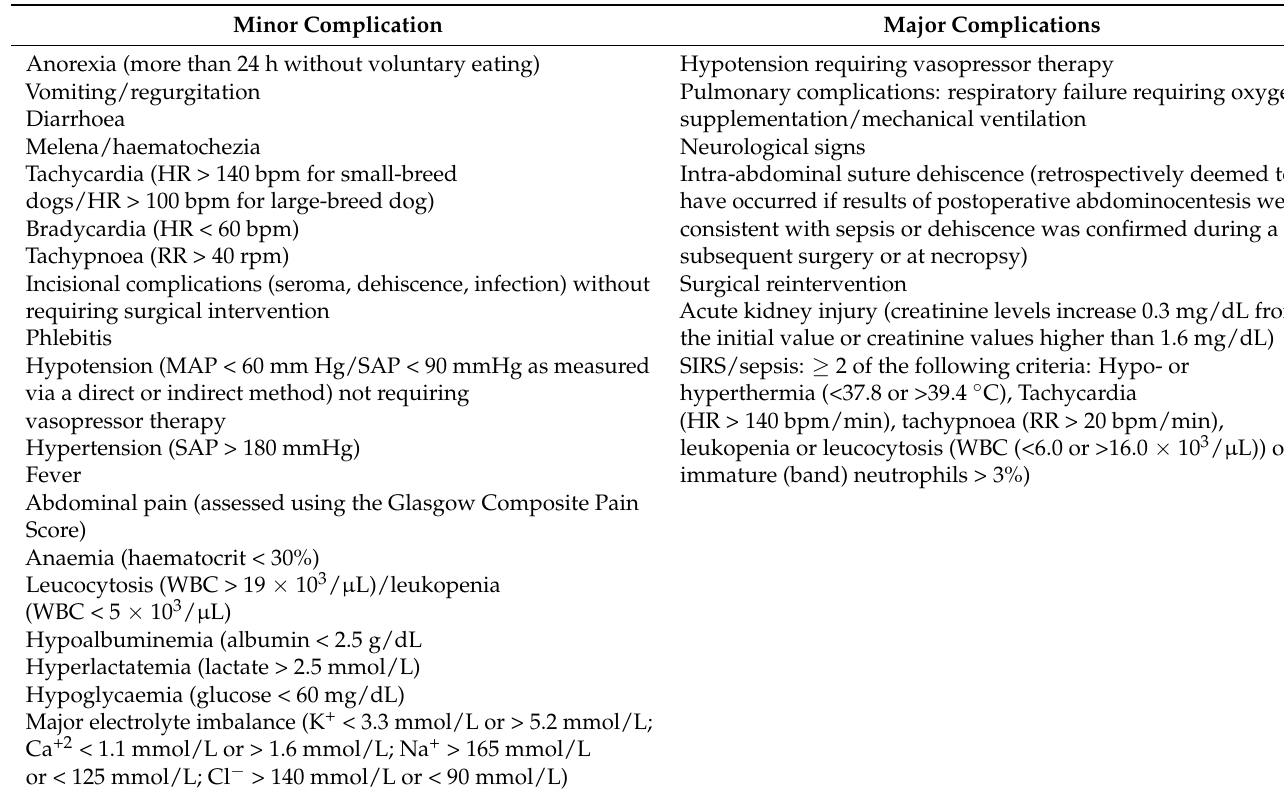
Table 2. Postoperative complications